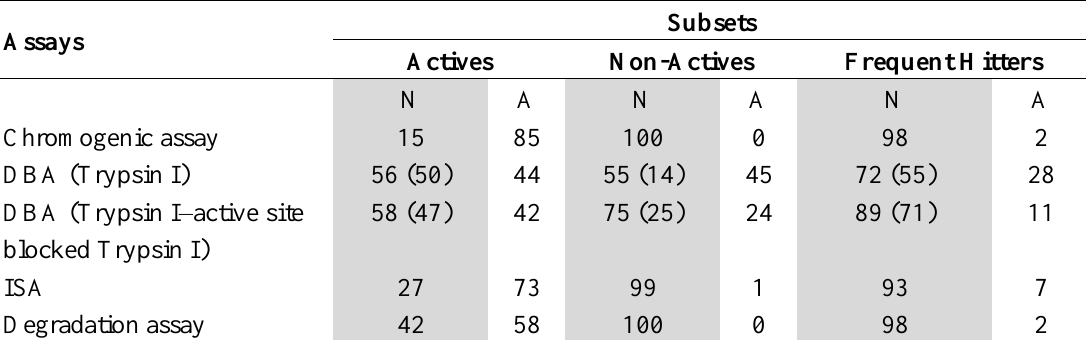
Table 3. Summary of the screening results for all assays. The results for the test set subsets are reported in % of the total. For the DBA, compounds showing unspecific binding (either high values compared to the expected maximum binding signal or similar binding to both trypsin I & active site blocked trypsin I) were classified as not being hits (N) and their % of the total is given in brackets. Hits are reported as